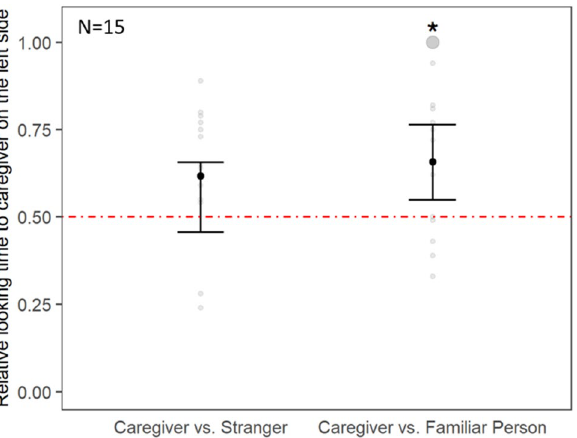
Figure 2. Dogs’ relative looking time to the caregiver presented on the left screen side in Experiment 2a (left; caregiver vs. stranger) and 2b (right; caregiver vs. familiar person). The red dash-dotted line represents the chance level (0.5), GLMM: * p < 0.05. The bootstrapped 95% confidence intervals of the model are indicated by the vertical black lines. The grey points represent the individual looking patterns of each dog per experiment. The size of the points is proportional to the number of